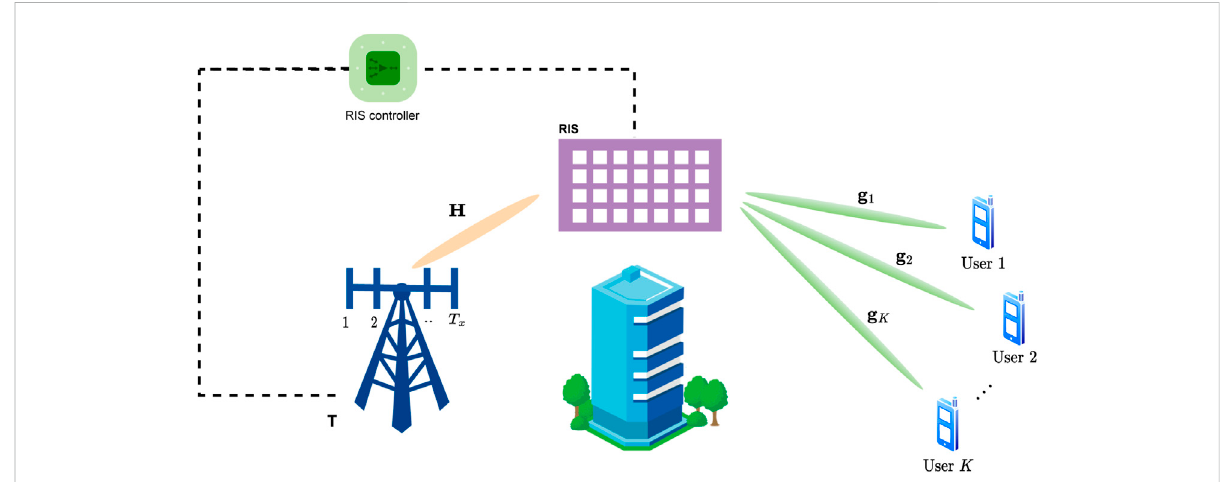
FIGURE 1 Over-the-air beamforming-based multi-user downlink transmission